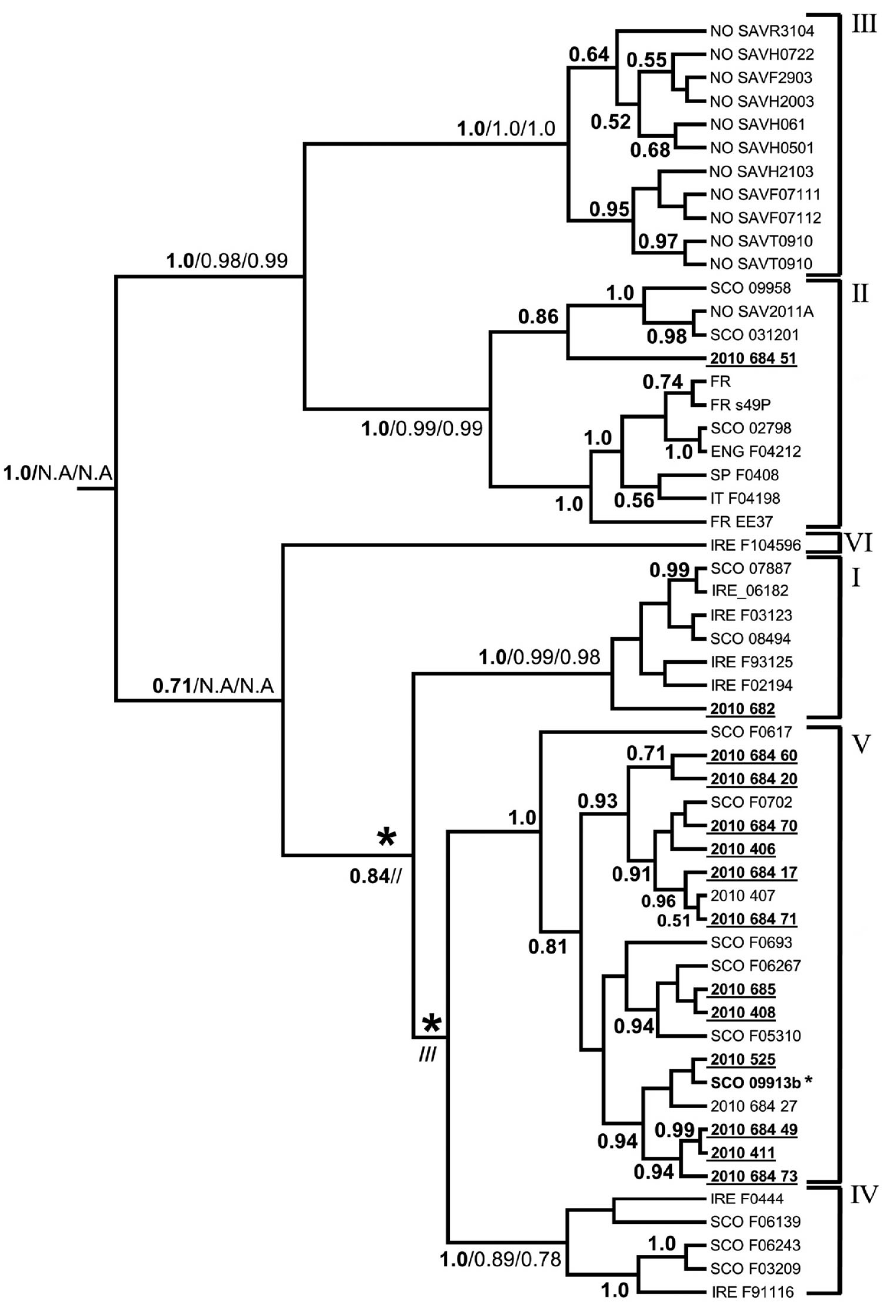
Fig. 3. Bayesian phylogenetic analyses performed with the 350 bp partial E2 gene se- quence. The analysis was performed using the best-fitting model of nucleotide substi- tution (K80+G). The maximum clade credibility tree shown is based on 90000 trees sampled from the MCMC chain after convergence was reached. Numbers at each node are support values from the different tree-building methods, ordered as: Bayesian posterior probability/ML bootstrap proportion/NJ bootstrap proportion (in all cases, only values >0.5 shown). Branch lengths are scaled to be relative in time accord- ing to an uncorrelated lognormal relaxed clock model. The asterisks on 2 internal nodes highlights the weak statistical support at branches separating defined sub- groups I, IV and V. Bold underlined branch labels are sequences from dab